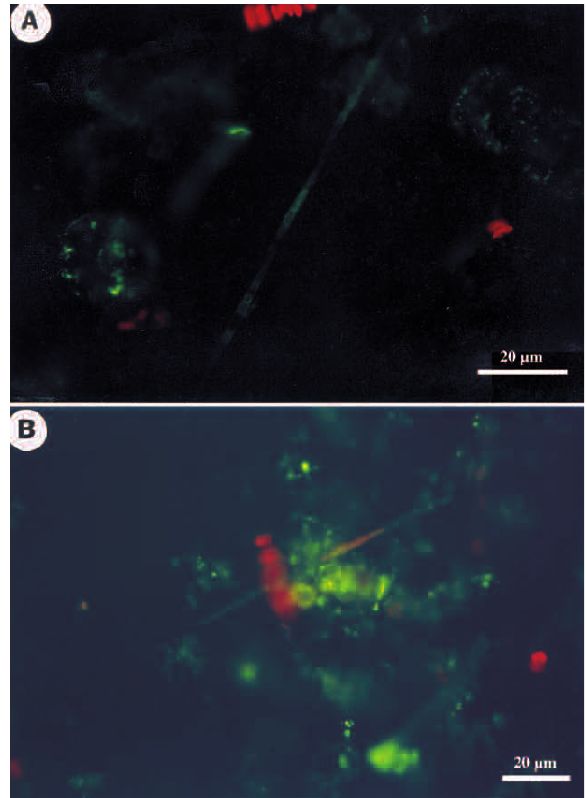
species-specific probe